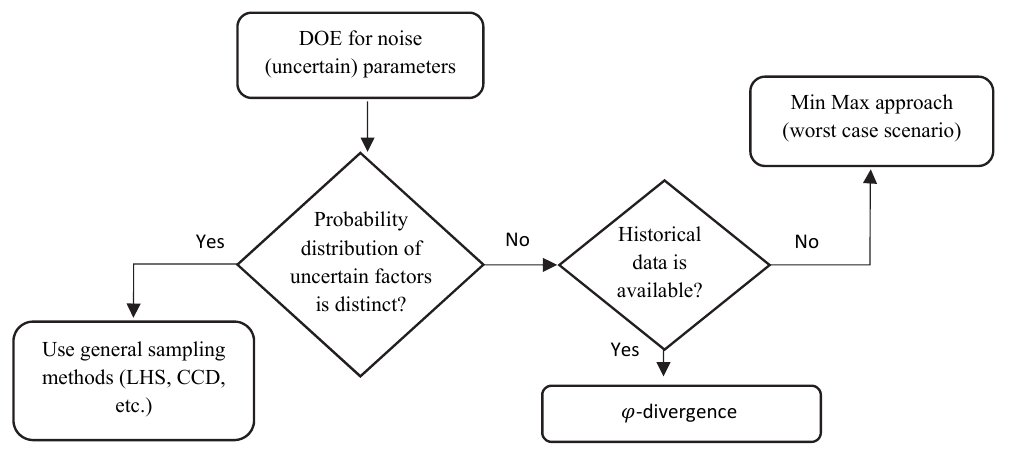
Fig. 8. The strategies in faced with unknown probability distribution of uncertain